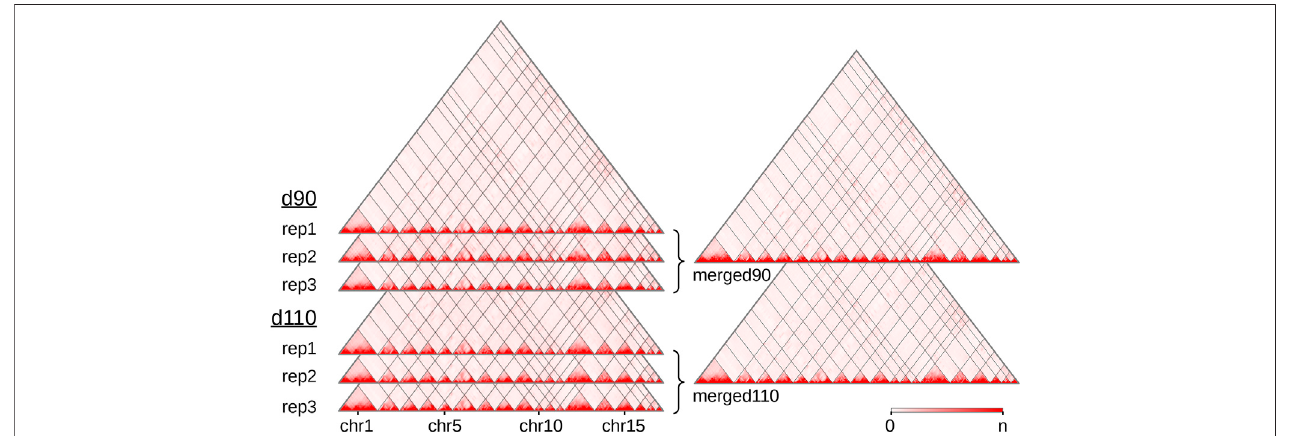
FIGURE 1 | Hi-C interaction maps of the porcine genome in fetal muscle. Interaction matrices of three biological replicates from two experimental groups (90 and 110 days of gestation) were displayed with the Juicebox tool, before and after merging them by group. The color intensity indicates the number of interactions between pairsofgenomicloci( x -axis,500 Kbperbin).Sincethecolorscaleisgeneratedforeachmatrixindependently,thehighestintensitycorrespondstothefollowingvaluesof n : 16,103 (rep1), 13,257 (rep2) and 11,461 (rep3) for d90, 13,022 (rep1), 7,150 (rep2) and 16,070 (rep3) for d110, 43,029 for merged90 and 37,866 for merged110. As the Sus scrofa v11.1 assembly version contains 613 scaffolds, only the 18 assembled autosomes are displayed. See also Supplementary Table 2